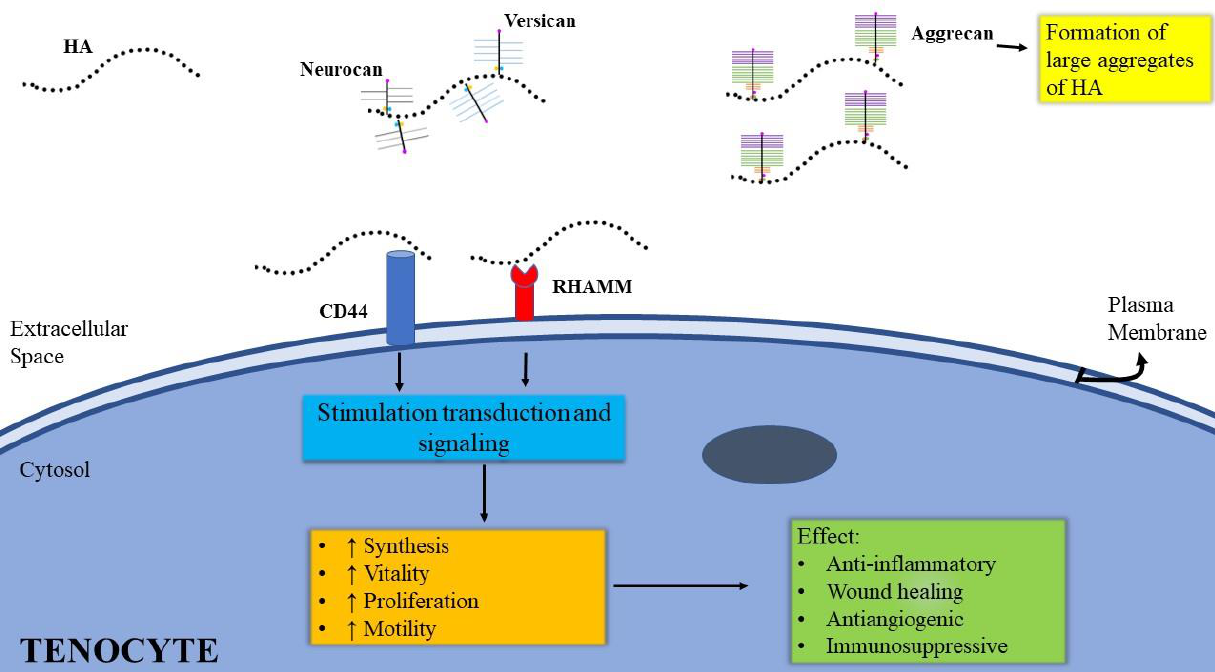
Figure 2. Effects of HA on tenocytes.